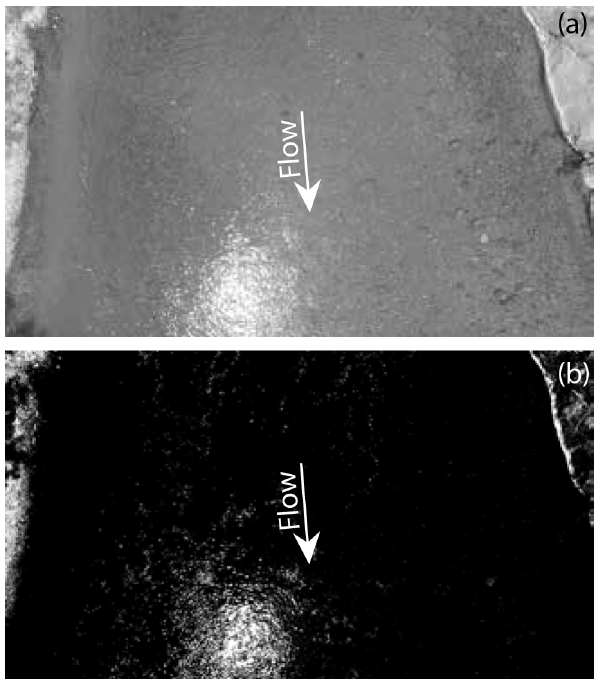
Figure 5. (a) Greyscale footage acquired by the Phantom 3 UAS over the River Noce and (b) the same image following contrast stretching. The direction of flow is indicated by the